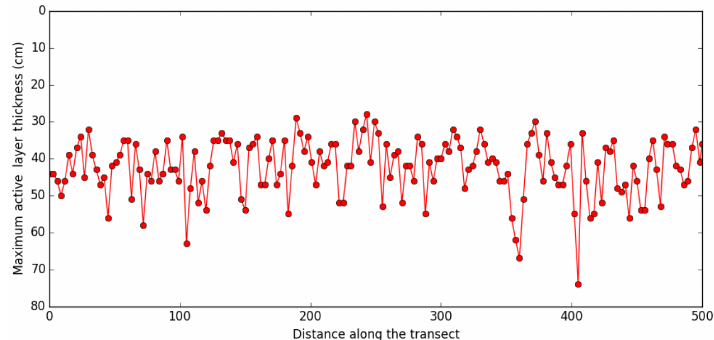
Figure F1. Observed maximum active layer thickness at the NGEE Arctic Site 0 (data collected on 2 July 2014, 16 August 2014 and 23 September